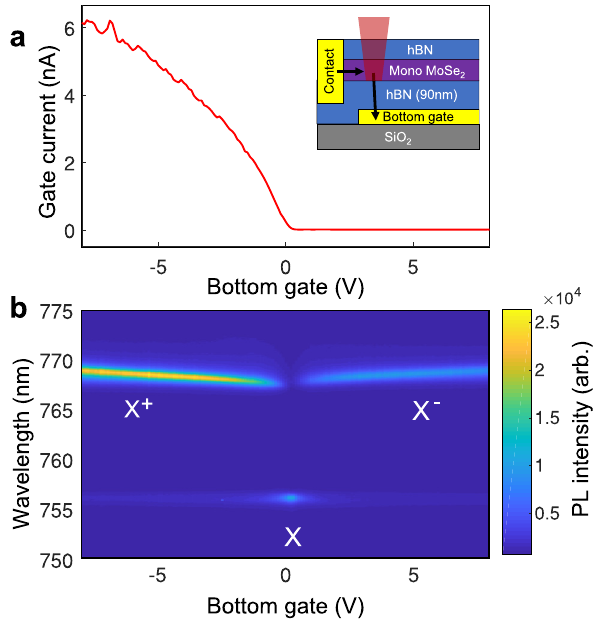
Figure 1: Consistent cross-hexagonal boron nitride (hBN)